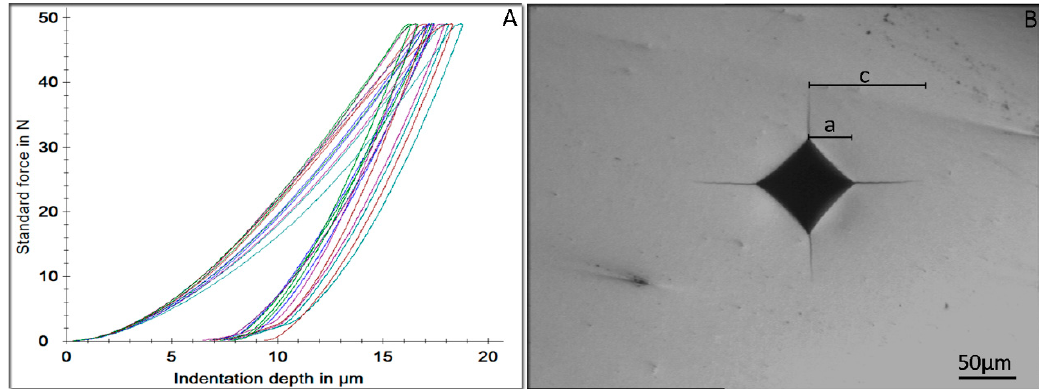
Figure 3. ( A ) Representative force indentation depth curves of the loading / unloading cycle from all tested materials. ( B ) Representative image of the Vickers impression from the surface of all tested materials. All cracks originated from the four corners of the Vickers impression. a —the half diagonal; and c —the distance from the center of the impression to the tip of the crack (bar: 50 µ m). Table 3. Mean values and standard deviations (in parentheses) of the tested mechanical properties. Material HM (N / mm 2 ) E IT